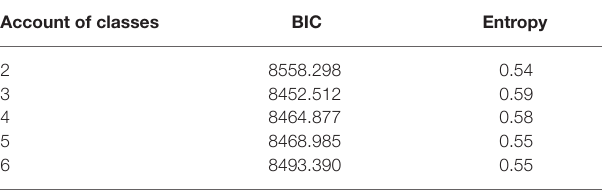
TABLE 2 | The fits for the results of the latent class analysis of the study. Account of classes